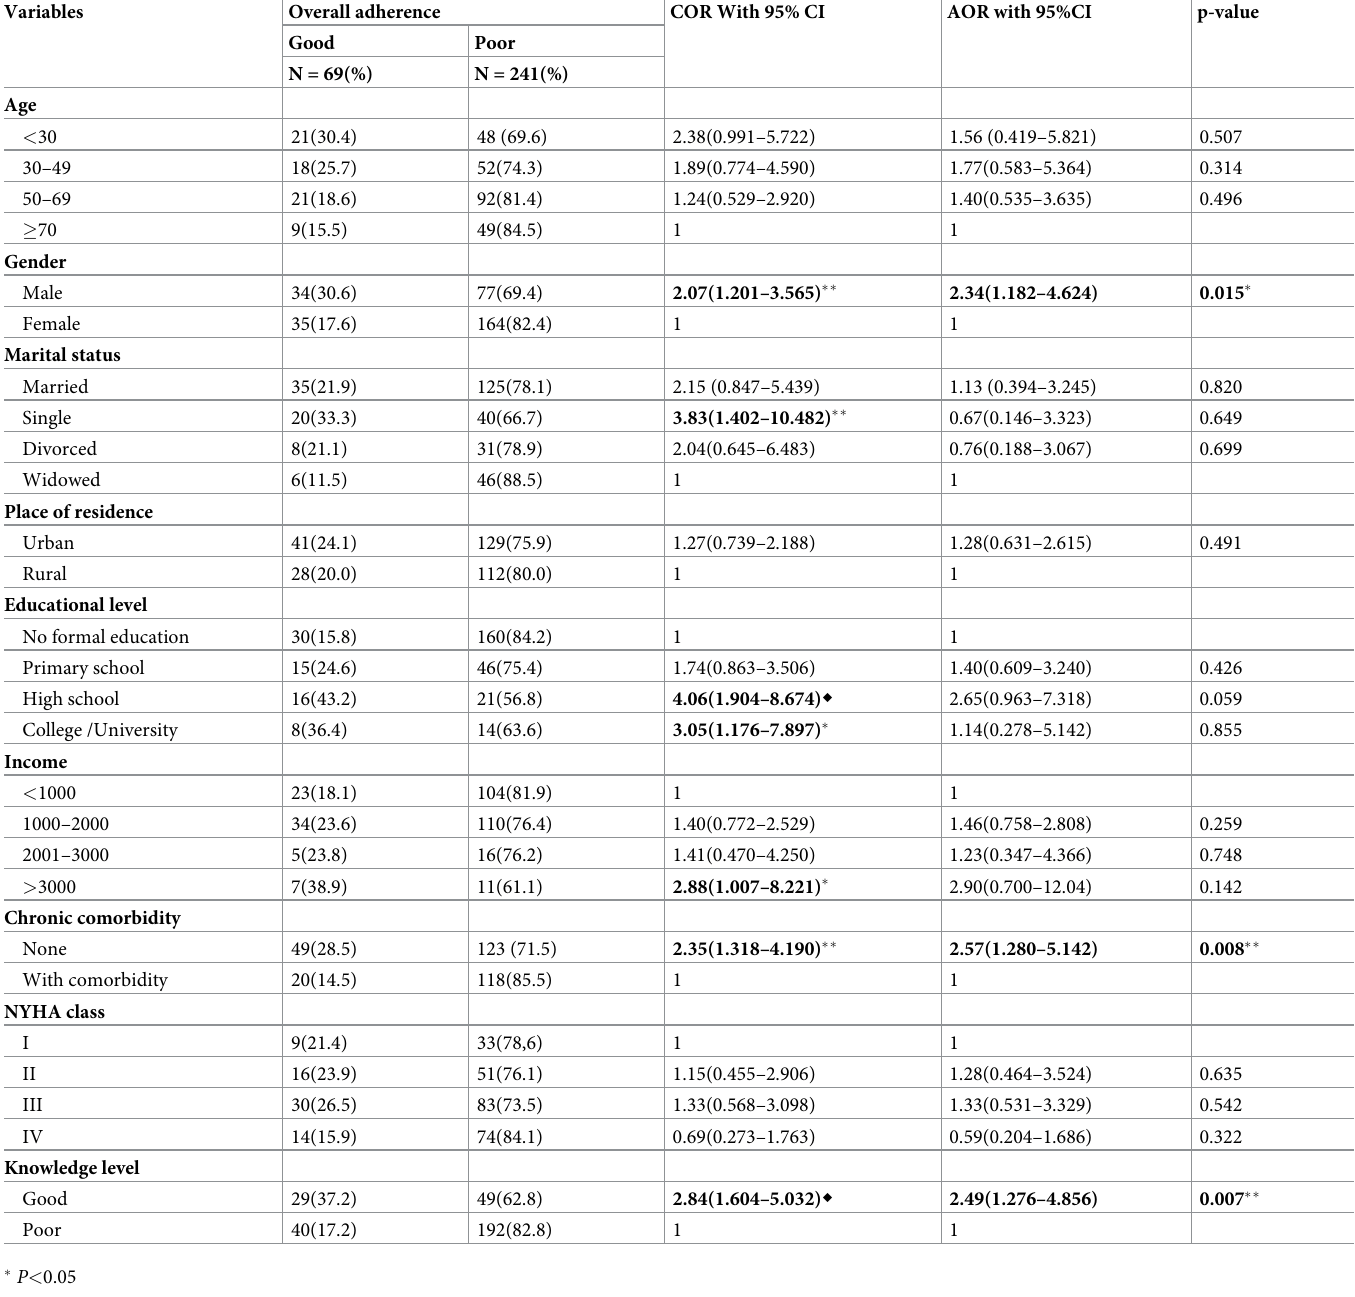
Table 3. Binary logistic regression analysis of factors associated with the overall adherence to self-care behaviors among heart failure patients at Gondar University referral hospital, Northwest Ethiopia, May 2017 (n =